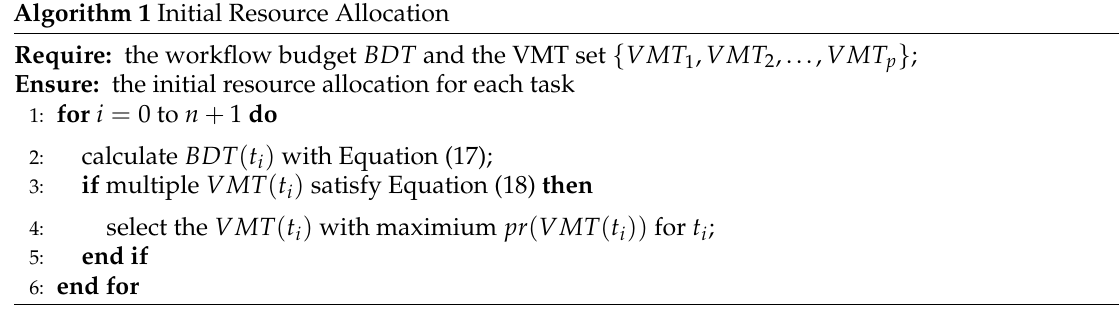
Algorithm 1 Initial Resource